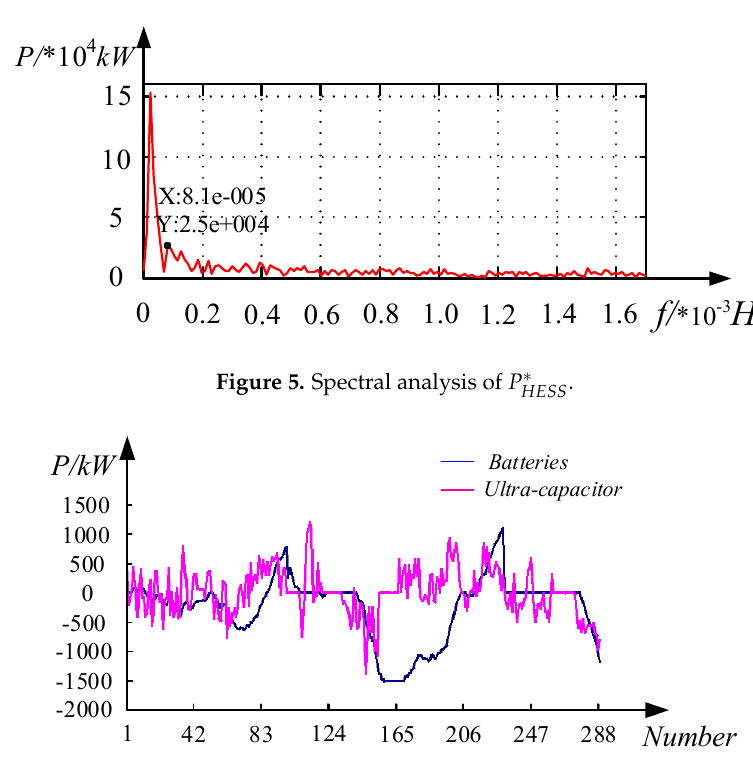
Figure 6. Charging and discharging power of the HESS.